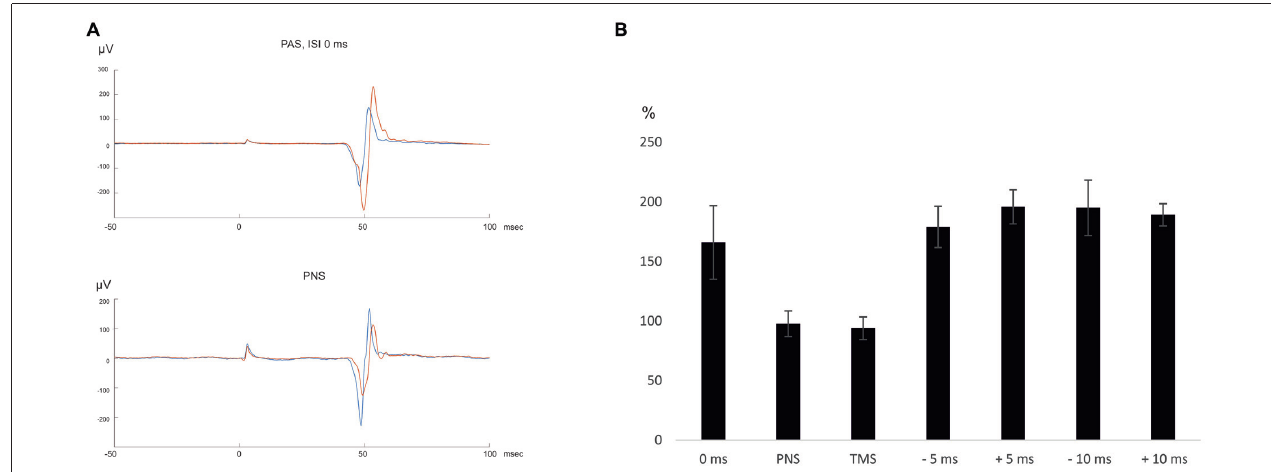
FIGURE 1 | (A) An average of 10 motor-evoked potentials (MEPs) recorded in a representative subject (subject 2). Blue—pre-paired associative stimulation (PAS)/peripheral nerve stimulation (PNS), red—post-PAS/PNS. (B) Summary of the results.